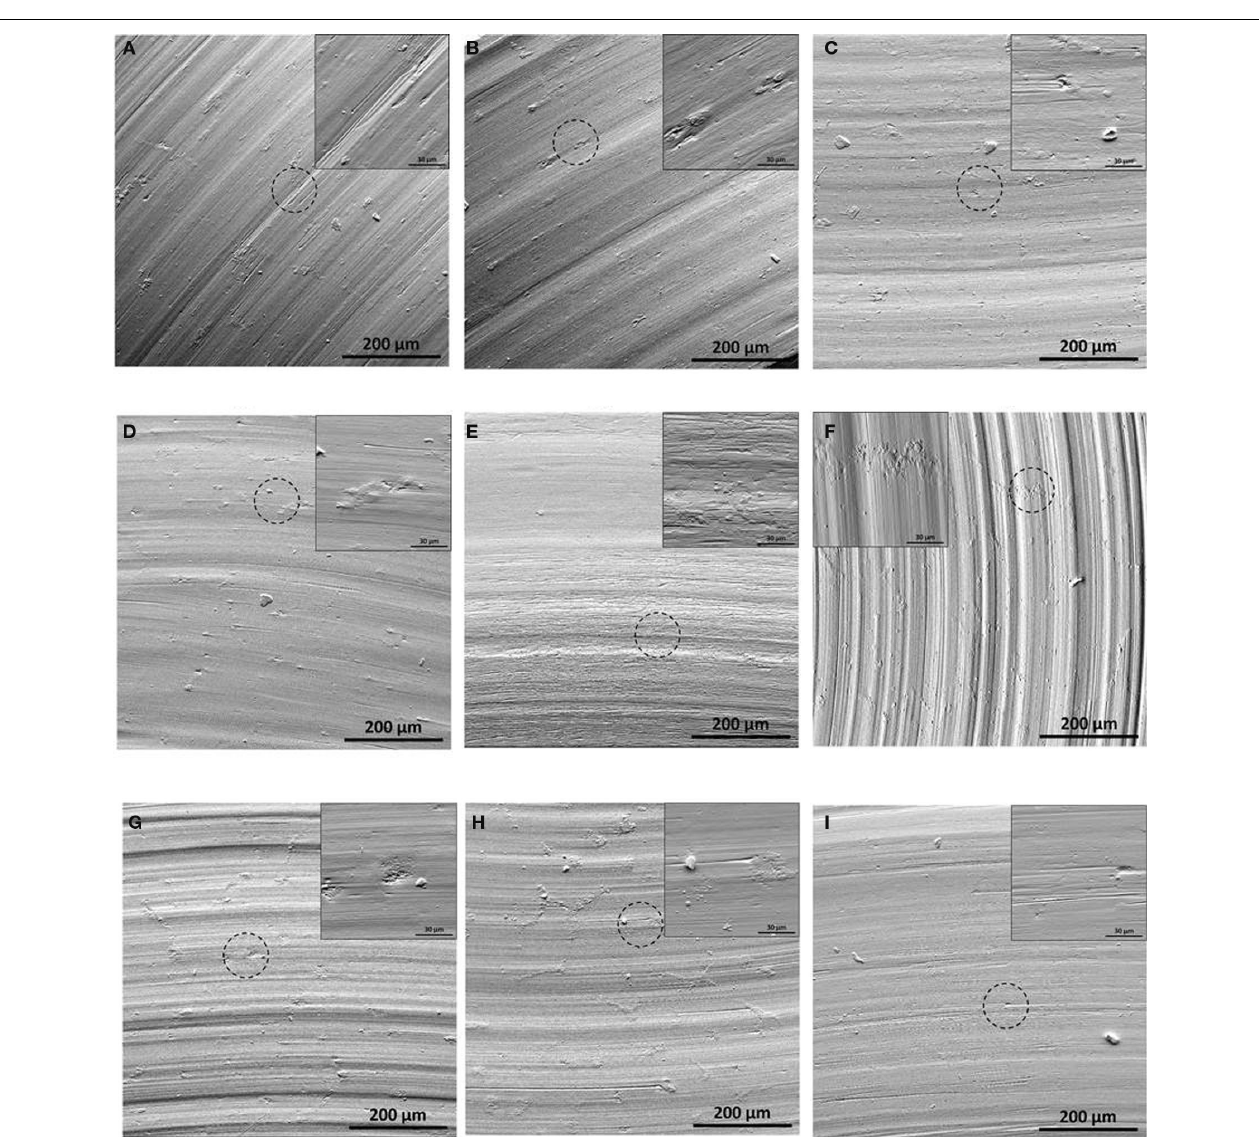
FIGURE 4 | Wear track morphologies of Co-Cr-Mo alloy samples (A–I) S1–S9 . Inset shows magnified image of region highlighted with circle.